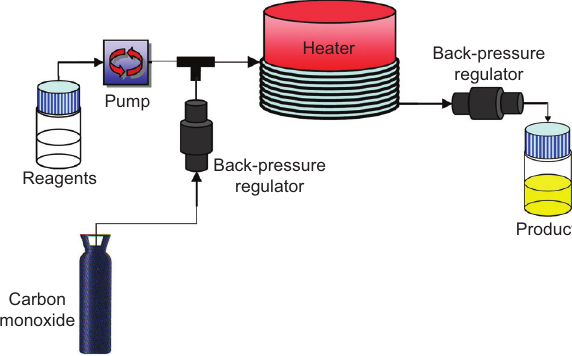
Figure 2 Gas-loading accessory interfaced with a single 80 ml reaction vessel. Figure 3 Modified flow reactor for introduction of CO